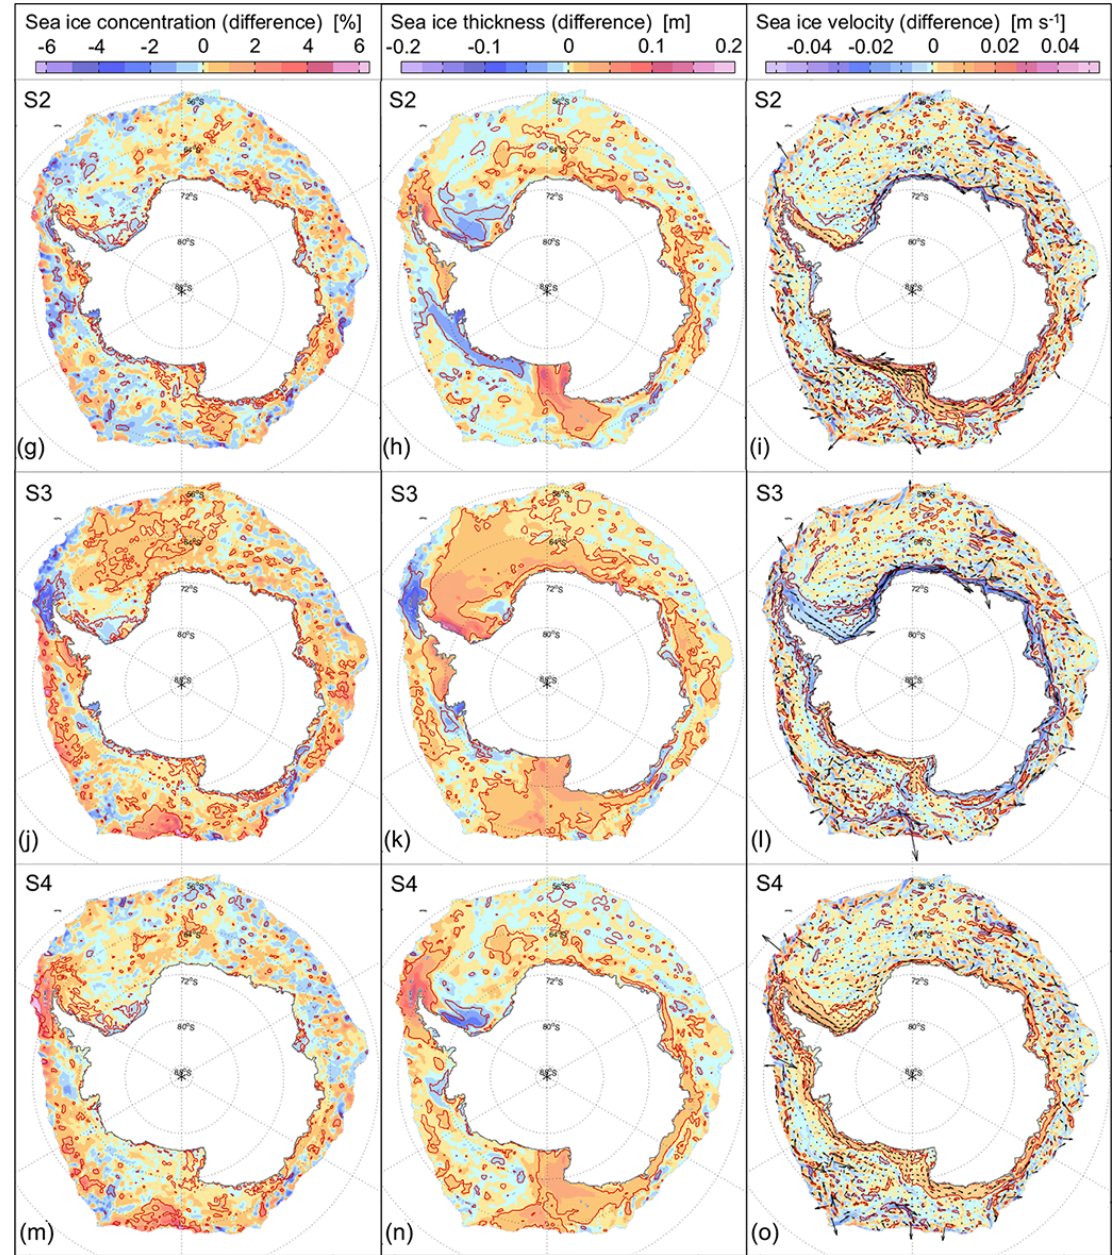
Figure 2. Maps of winter sea ice (a) concentration, (b) thickness, and (c) velocity in CTR averaged over April–September 2004–2013. (d–o) Difference of ice concentration (left), thickness (middle), and velocity (right) between respective experiment and CTR. The colors underlying the velocity arrows indicate the difference in vector magnitude (speed). Dark red contours encompass the areas where the significance of the difference surpasses the 99% confidence level of the Student t test for dependent samples, where the mean difference between two samples (here: time series) is set in relation with the standard deviation of the